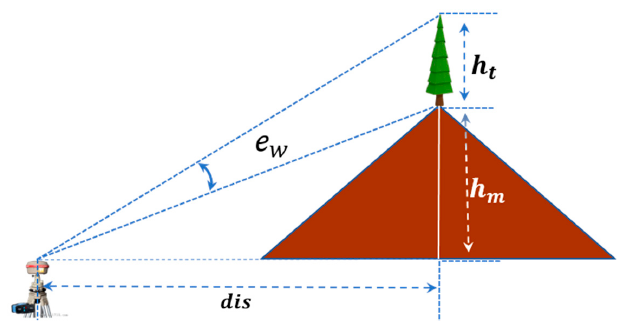
Figure 3. The geometric relationships among the specified range ( e w ), height of a mountain peak ( h m ), and horizontal distance ( 𝑑𝑖𝑠 ) between an antenna and the peak.